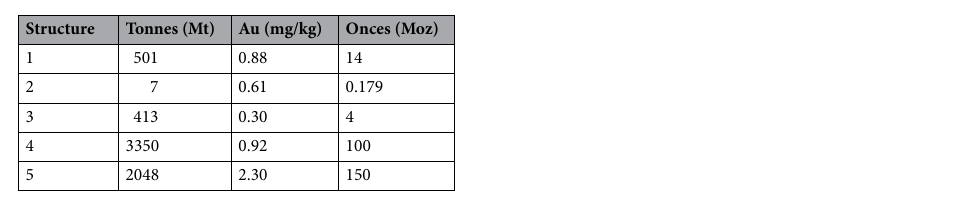
Table 4. Estimation resources of Au for deposit 1 to 5.